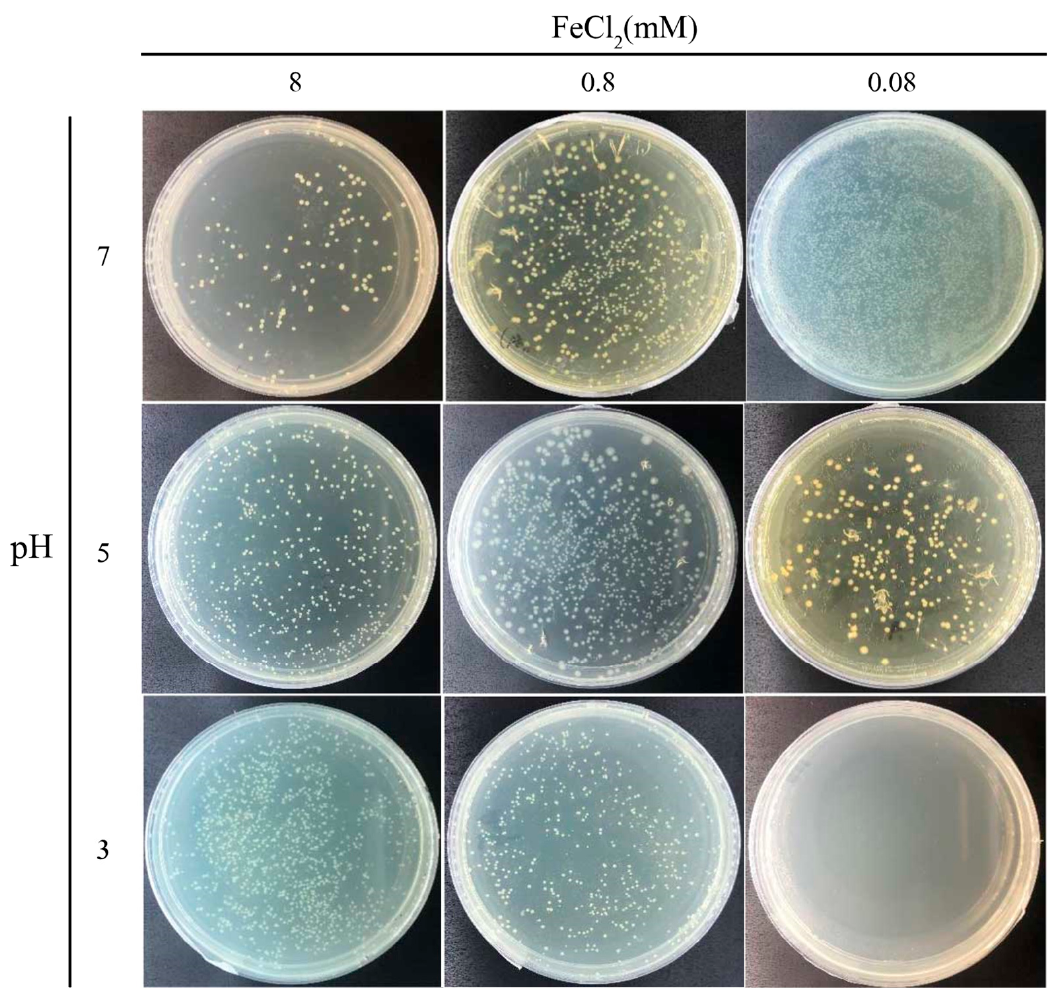
Figure 5. Cell viability after magnetic MIP. Photos of plates of MIP cells treated using buffers of different pH to release cells from the precipitates.